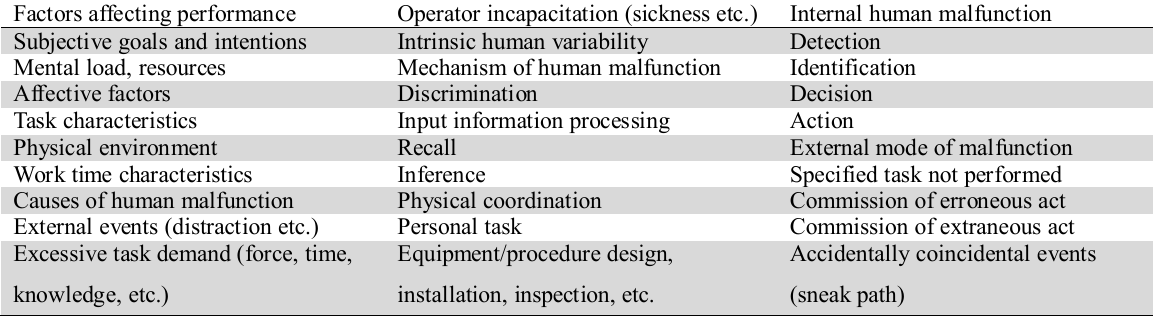
Multifaceted human error taxonomy (Adapted from Rasmussen, 1982) Factors affecting performance Operator incapacitation (sickness etc.) Internal human malfunction Subjective goals and intentions Intrinsic human variability Detection Mental load,